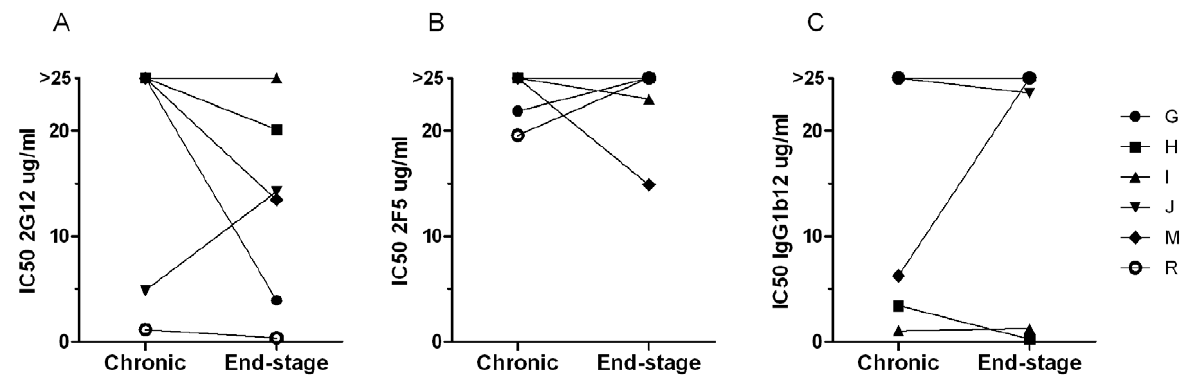
Figure 2. Sensitivity of sequential R5 viruses to neutralization by the 2G12, 2F5 or IgG1b12 monoclonal antibodies. Depicted are a) 2G12, b) 2F5 and c) IgG1b12 IC50 results from the analysis of neutralization sensitivity of sequential chronic and end-stage R5 viruses tested with each individual monoclonal antibody.